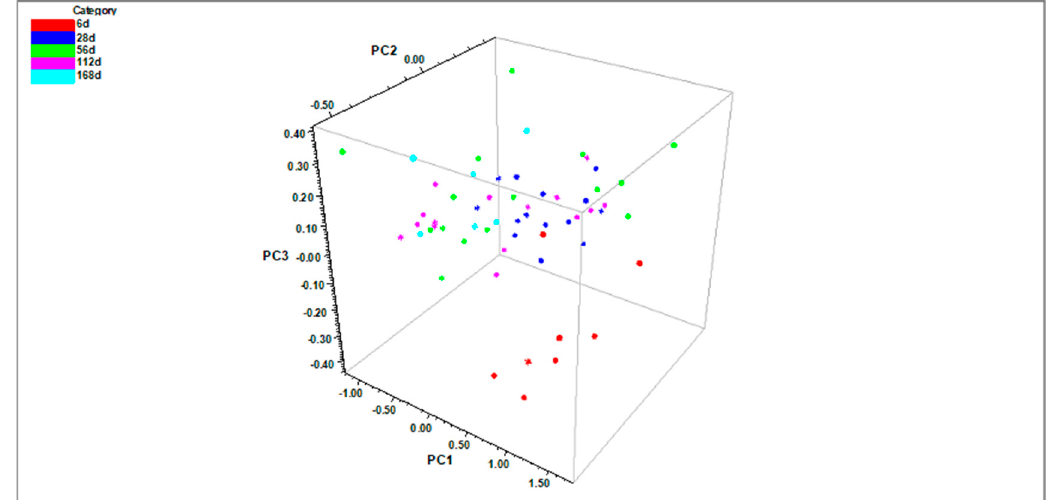
Figure 4. Principal Component Scores of three-dimensional plot of cheese water-soluble extracts of five different classes, according to days of ripening; PC, principal component; 6 d, 6 days; 28 d, 28 days; 56 d, 56 days; 112 d, 112 days; 168 d, 168 days.